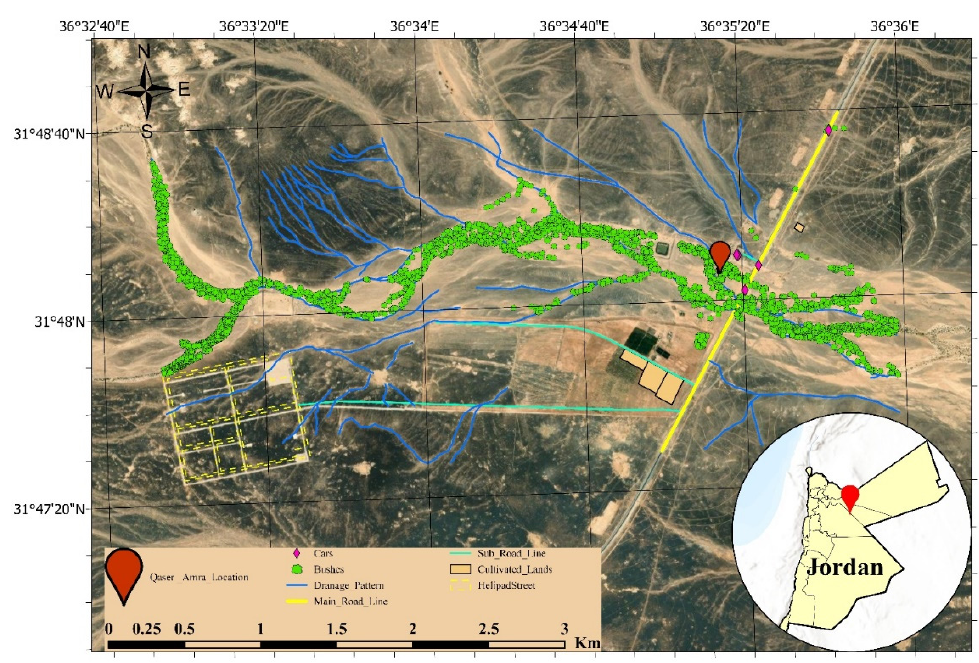
Figure 12. Overlay of GIS layers and orthophoto forQaser Amra.